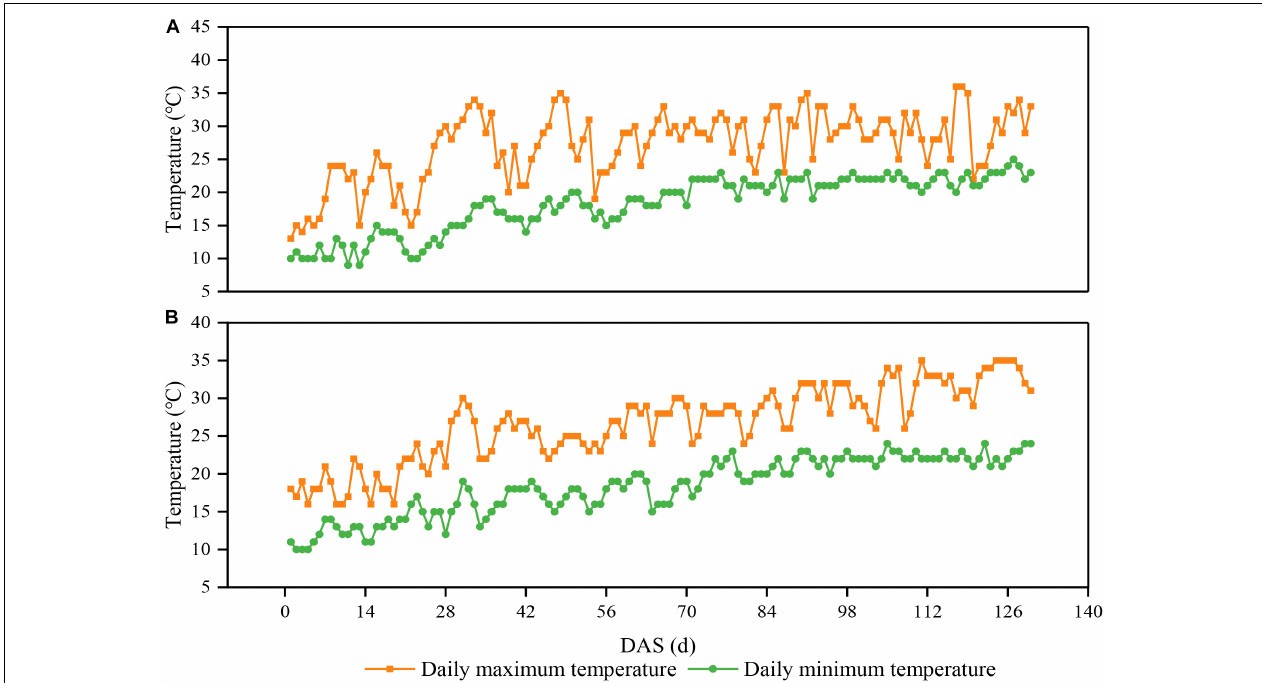
FIGURE 1 | Daily maximum and minimum temperatures above the soybean canopy from sowing to harvest in 2020 (A) and 2021 (B) in Chongzhou, Sichuan, China. Orange lines and boxes represent the daily maximum temperature, whereas green lines and circles represent the daily minimum temperature. DAS represents the number of days after sowing.